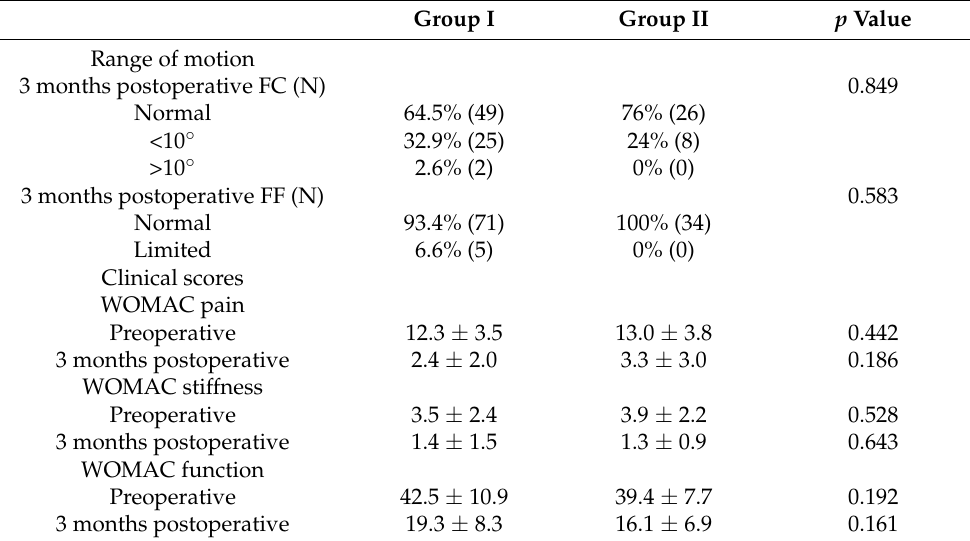
Table 4. Patients’ clinical outcomes by study